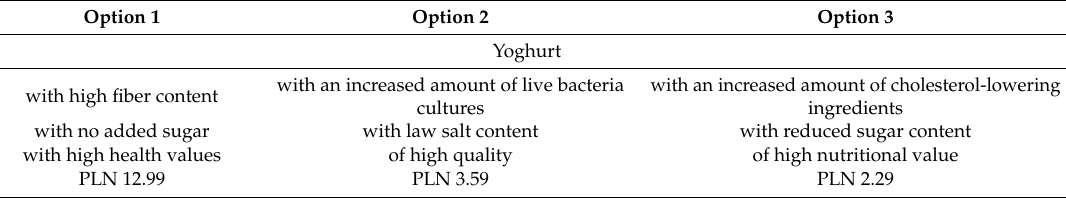
Table 2. Example of the discrete choice-based experiment screen used in the